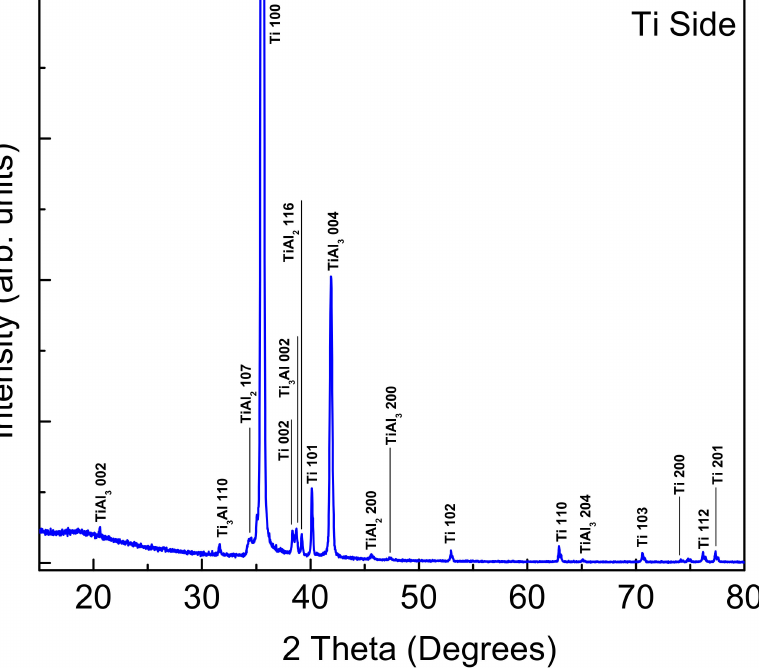
Figure 5. XRD pattern of the fractured surface (Ti-6Al-4V side) for the sample bonded at 520 ◦ C, holding pressure of 10 MPa, and holding time of 10